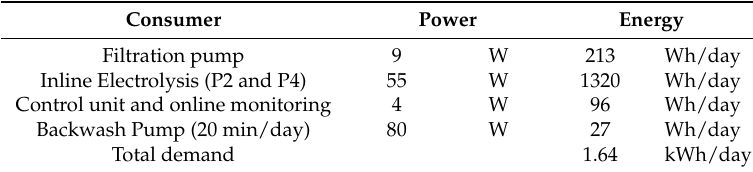
Table 6. Energy requirements for water treatment (as in P2 and P4).